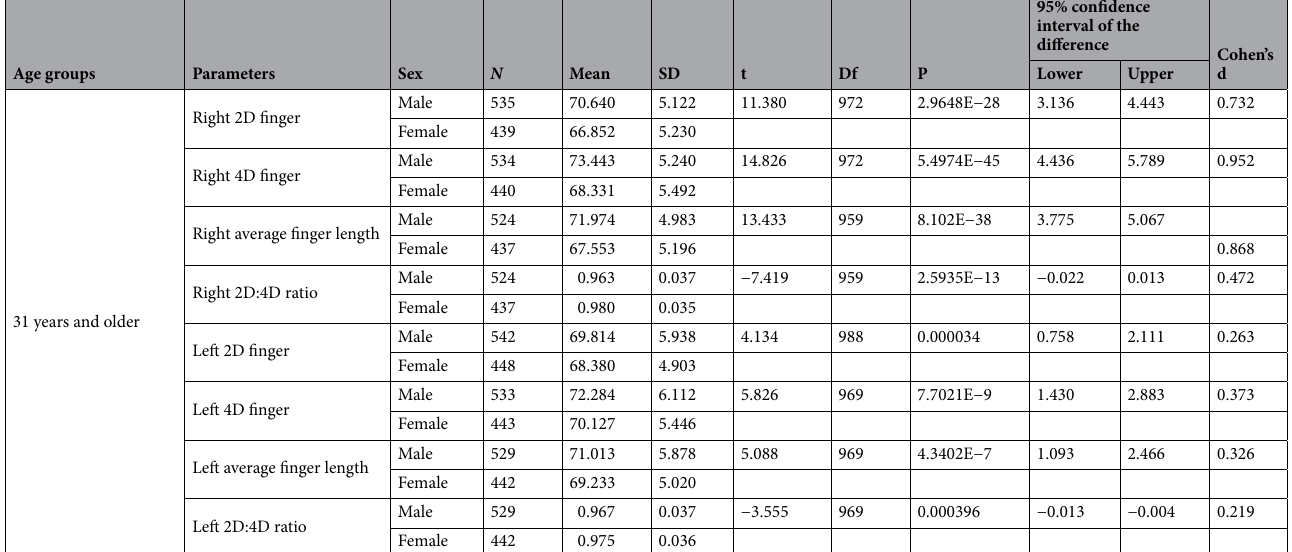
Table 3. Sex differences in finger measurements and 2D:4D ratios for both hands in prepubertal, pubertal, young and older adults age cohorts. Sex differences presented according to Student’s T test ( t test statistics, SD std. deviation, df degrees of freedom, p statistical significance).